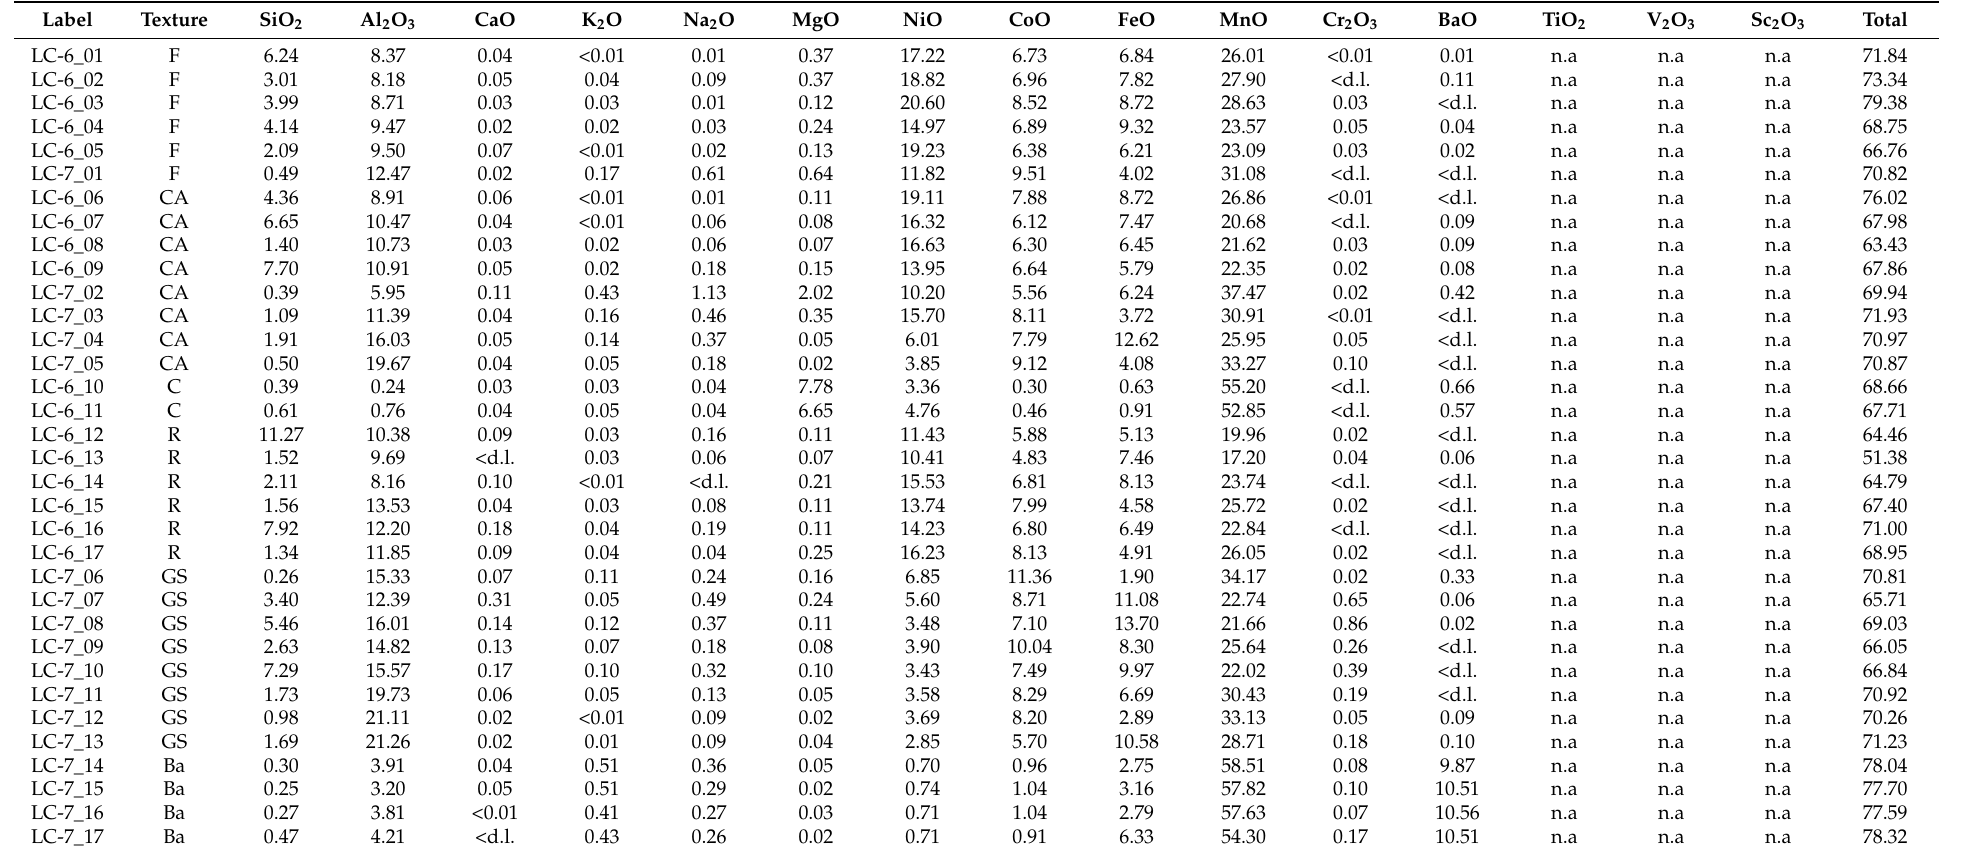
Table 1. Representative EMP analyses (in weight percent) of the studied Co–Mn-oxyhydroxide types in Loma Caribe (Dominican Republic). <d.l.: below detection limit; n.a: not analysed; F: fibres; CA: colloform aggregates; C: core; R: rim; GS: globular spherulitic aggregates; Ba: Ba-rich